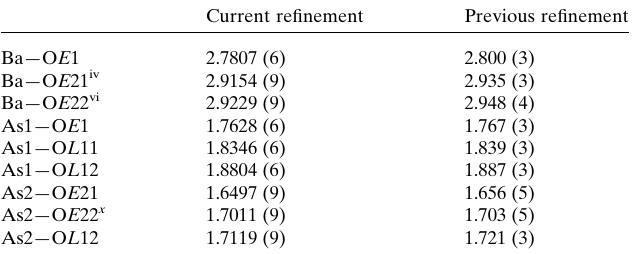
Table 1 Comparison of selected bond lengths (A˚ ) from the current and the previous (Blum et al. , 1977) refinement of BaH 6 As 4 O 14 . In the previous refinement, a = 8.496 (3), b = 11.249 (8), c = 5.858 (3) A˚ ; T = 298 K; R =